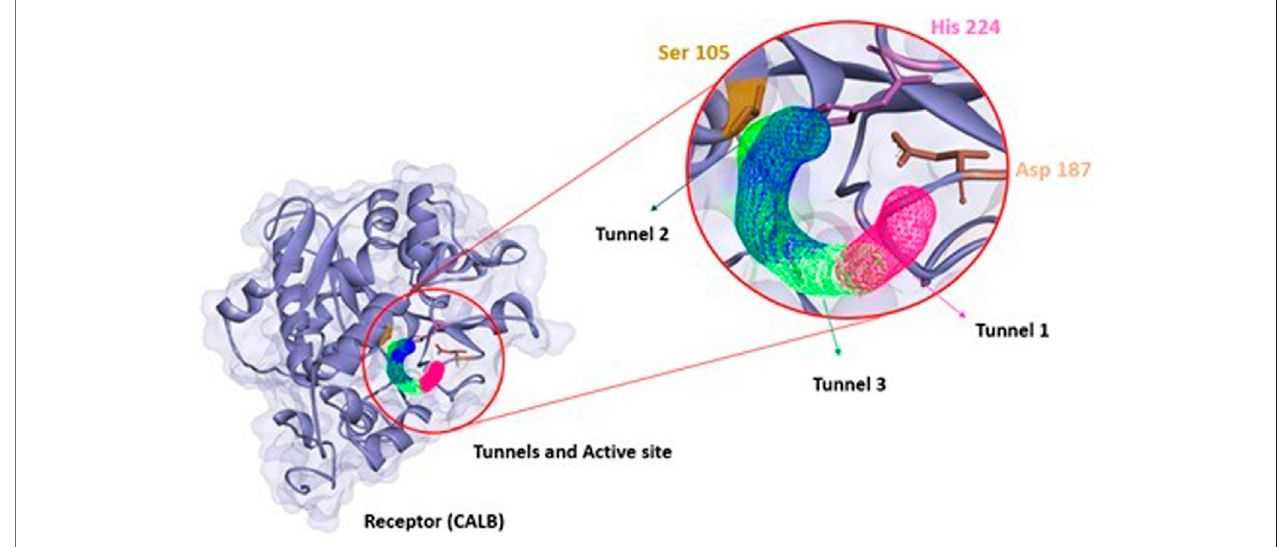
FIGURE11 | (A) Structural representation ofreceptor (CALB), active site (Ser 105, Asp 187 and His 224) in relation toposition of tunnel 2, the ligand ( α -tocopherol acetate) and (B) product α -tocopherol acetate (purple) in tunnel 2 (blue) apllied Caver Web in protein.